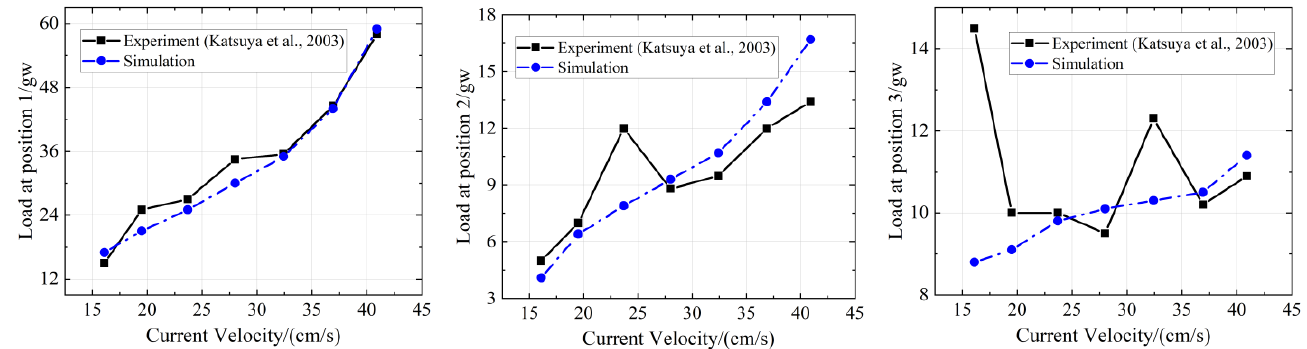
Figure 10. The comparison of the tension loads of net type B [36].